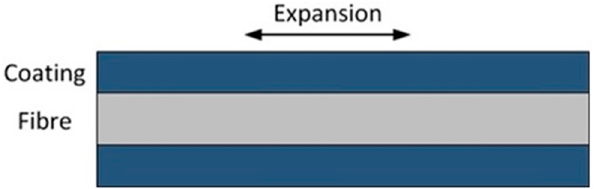
Figure 13. Optical fibre used for chemical sensing based on strain changes induced by a coating that expands in response to an analyte.